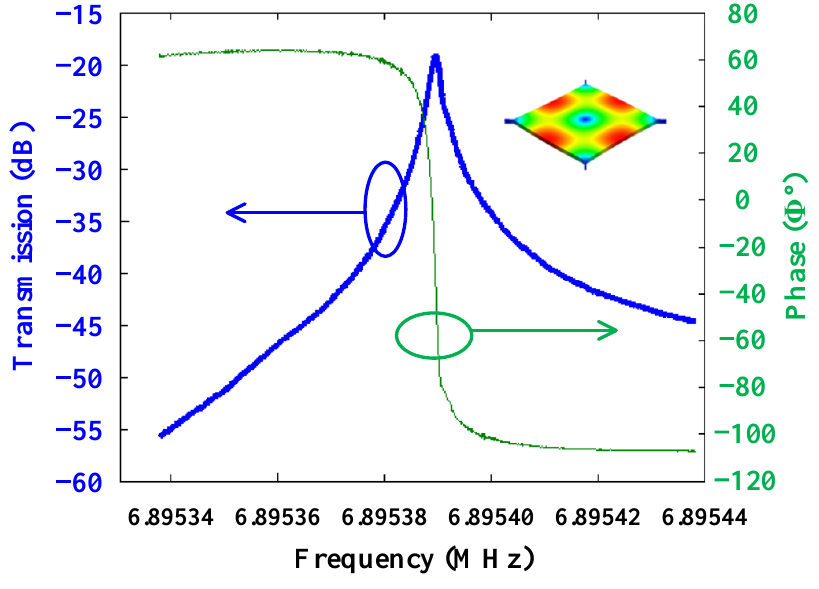
Figure 3. Measured MEMS electrical transmission (S21): the blue curve is the magnitude (left y -axis), and the green curve is the phase (right y -axis)